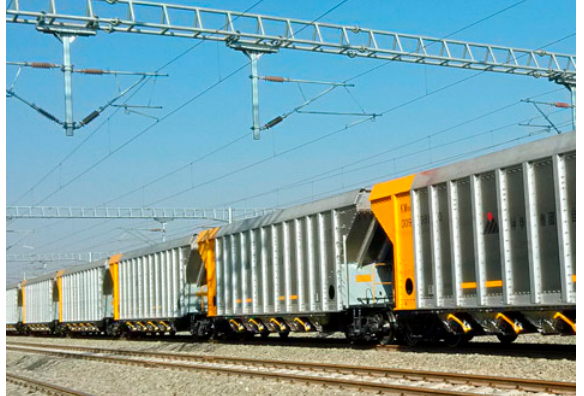
Figure 1. heavy-haul train with increasing axle load. Figure 1. Heavy-haul train with increasing axle load.